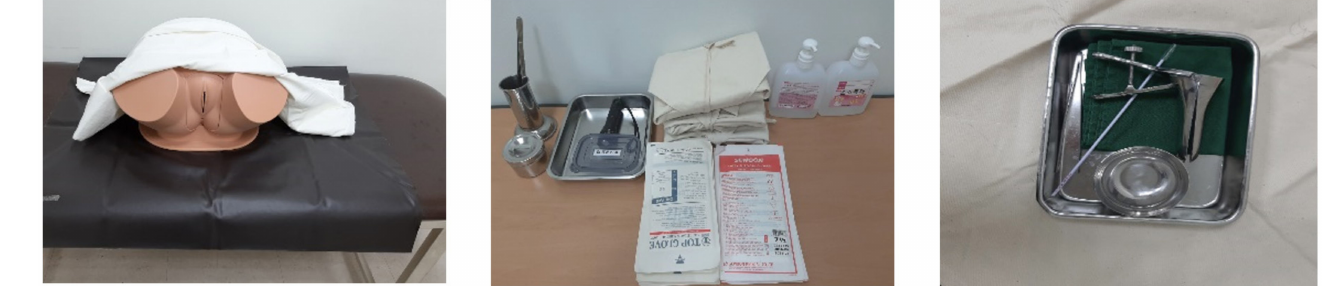
Figure 3. Preparations of Pap smear simulation problem-based learning. Table 1. Checklist of items of Pap smear simulation problem-based